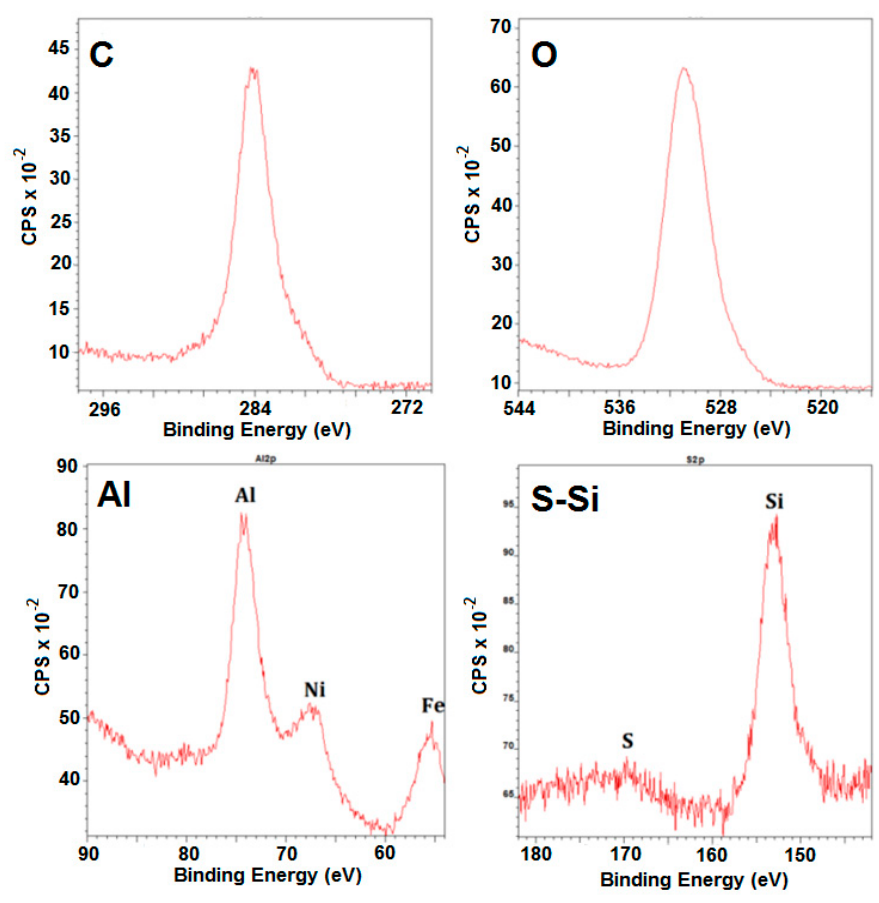
Figure 13. XPS-spectra for the di ff erent elements in sulfided coated sample.